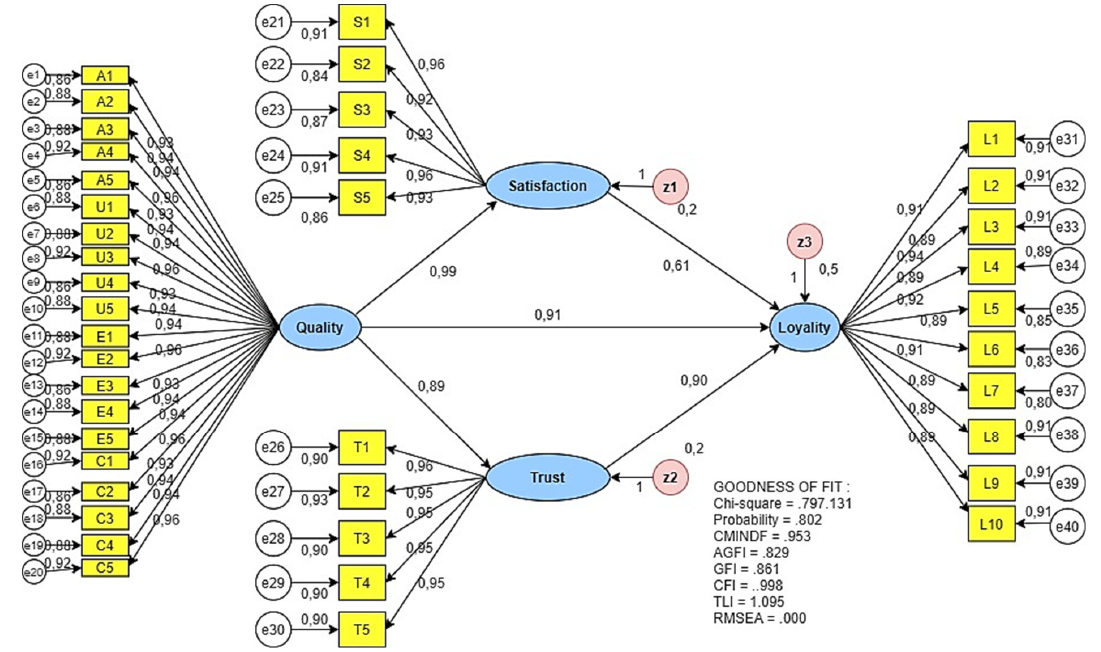
Fig. 2. Structural Model (SEM)